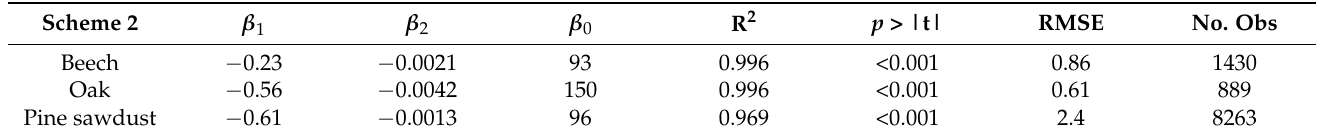
Figure 9. Relationship between Ref probe’s output: ECf and sample temperature versus the digital balance output: stem volumetric water content across the selected samples, ( a ) Beech, ( b ) Oak, and ( c ) pine sawdust.